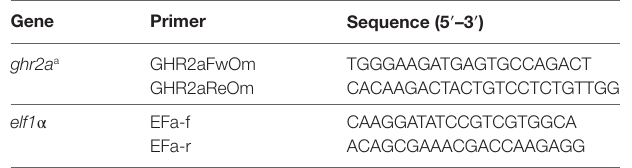
TaBle 1 | Primer nucleotide sequences used for quantitative PCR analysis of rainbow trout hepatic growth hormone receptor gene 2a ( ghr2a ) and reference gene elf1 α in experiments I and II.